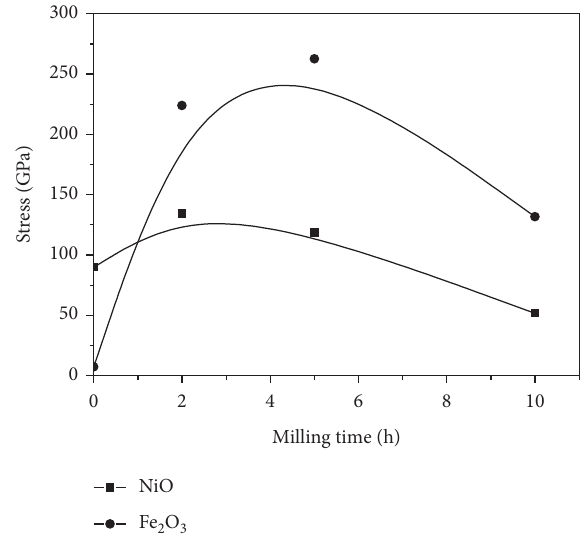
Figure 8: The micro-residual stress in the milled powders.